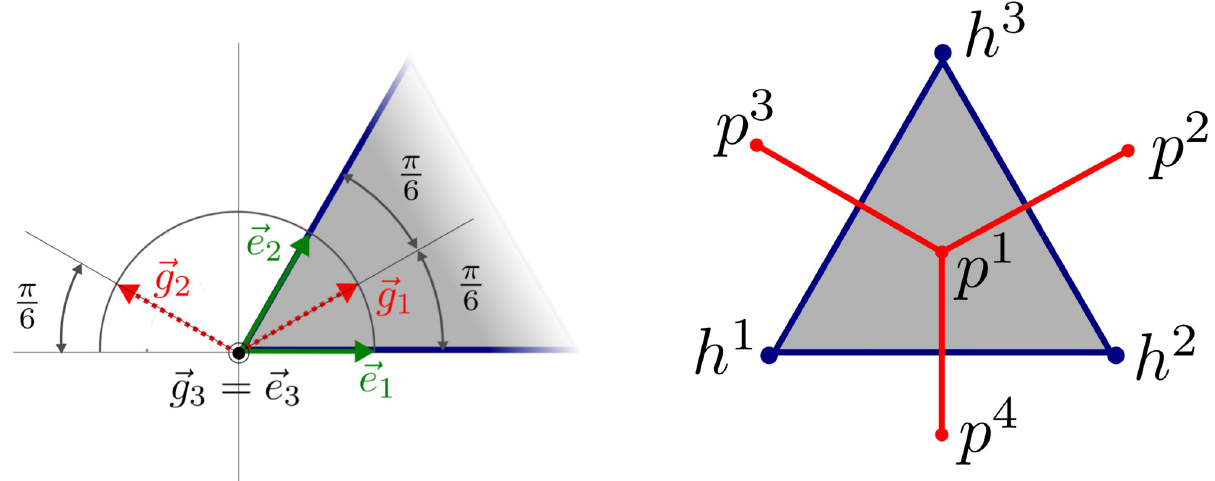
Fig 3. Positions of the nodes generating the primary and dual lattices. Left: The generating unit is defined using unit vectors of the primary and dual bases, { e i } and { g i }, respectively. Right: position of the vertex p k and the central h k points within the generating unit—the portal lobule.